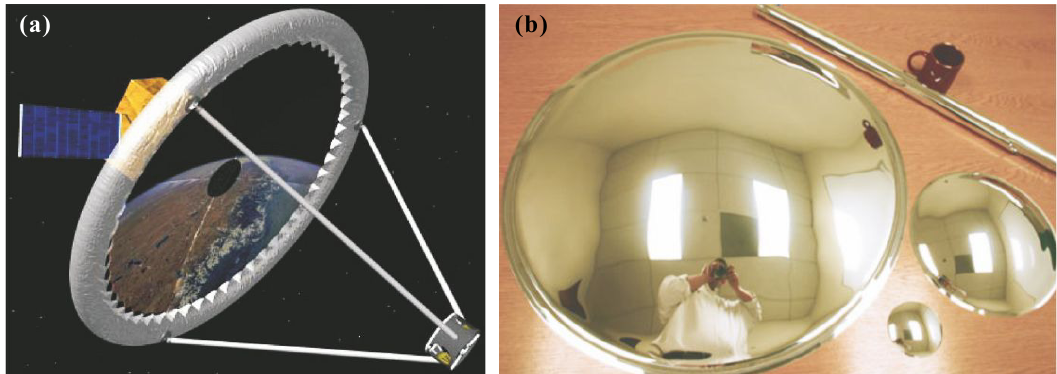
Figure 1. ( a ) Lenticular membrane reflector (source: NASA). ( b ) Polyimide thin shell reflector in deployed and rolled configurations (source: